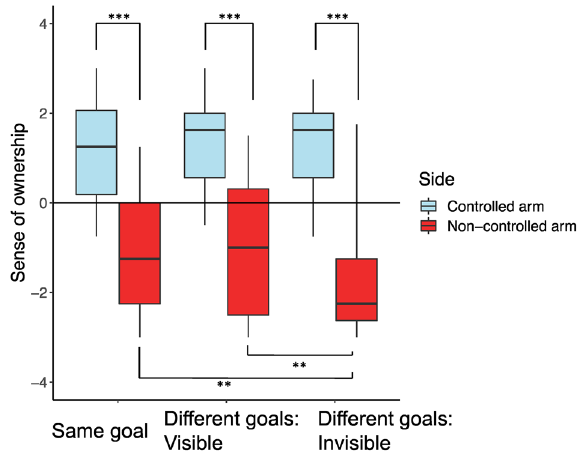
Figure 4. Sense of body ownership towards the controlled and non-controlled arms of the joint avatar in same goal, different goals: visible and different goals: invisible conditions. The ownership towards the non-controlled arm in the same goal and different goals: visible conditions were significantly higher than the ownership towards the non-controlled arm in the Different goals: invisible condition. In all three conditions, the ownership scores towards the controlled arm were significantly higher than the ownership scores towards the non-controlled arm.